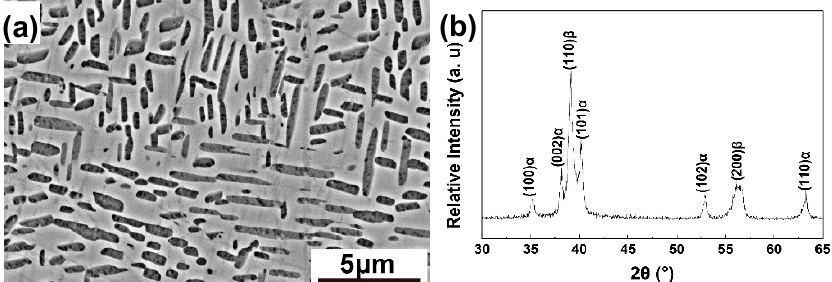
Figure 1. ( a ) Back-scatter Scanning Electron Microscopy (SEM) image and ( b ) XRD pattern of Ti-35421 after solid solution.